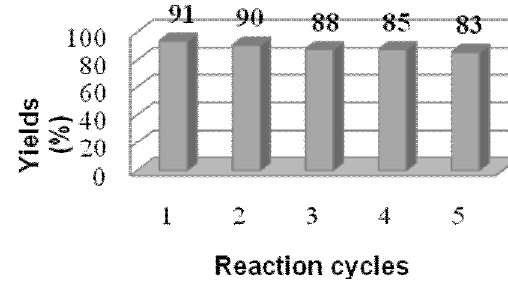
Fig. 2 . Reusability of catalyst in the presence of 4-nitro Iodobenzene